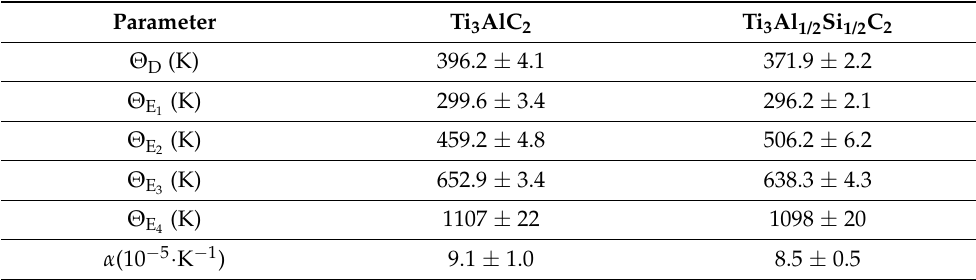
Table 4. The Debye ( Θ D ), Einstein ( Θ E ) temperatures, and anharmonic coefficients ( α ) obtained from the fitting of Equation (4) to the C p vs. T dependences from Figure 7 for Ti 3 AlC 2 and Ti 3 Al 1/2 Si 1/2 C 2 compounds. In the refinement, the Sommerfeld ( γ ) coefficients were fixed at corresponding values from Table 3 and the multiplicities m i of the Θ E parameters were set equal to 3, except of the m 3 (for Θ E 3 ) which was set equal to 6.